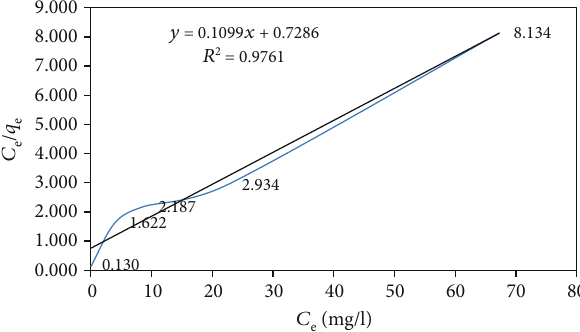
Figure 10: Langmuir adsorption